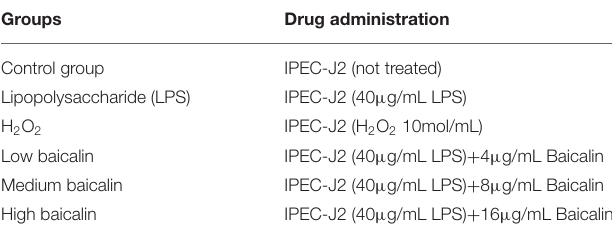
TABLE 1 | Experimental groups and drug concentrations. Groups Drug administration